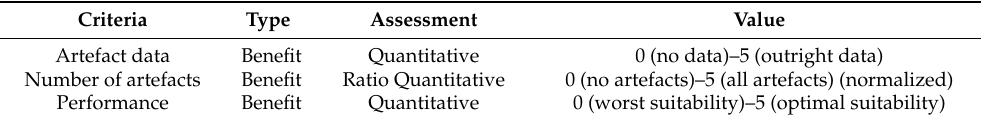
Table 2. Criteria: type, assessment, and